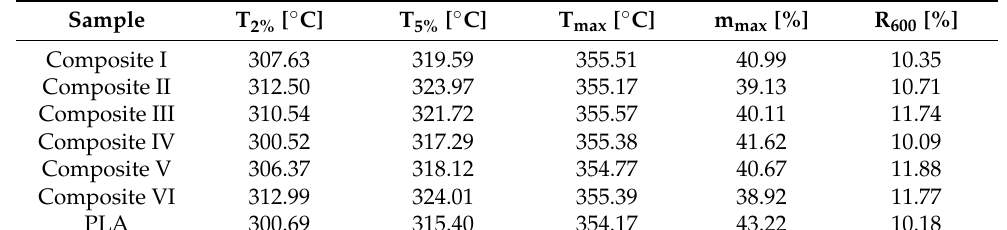
Table 5. Thermogravimetric analysis results.